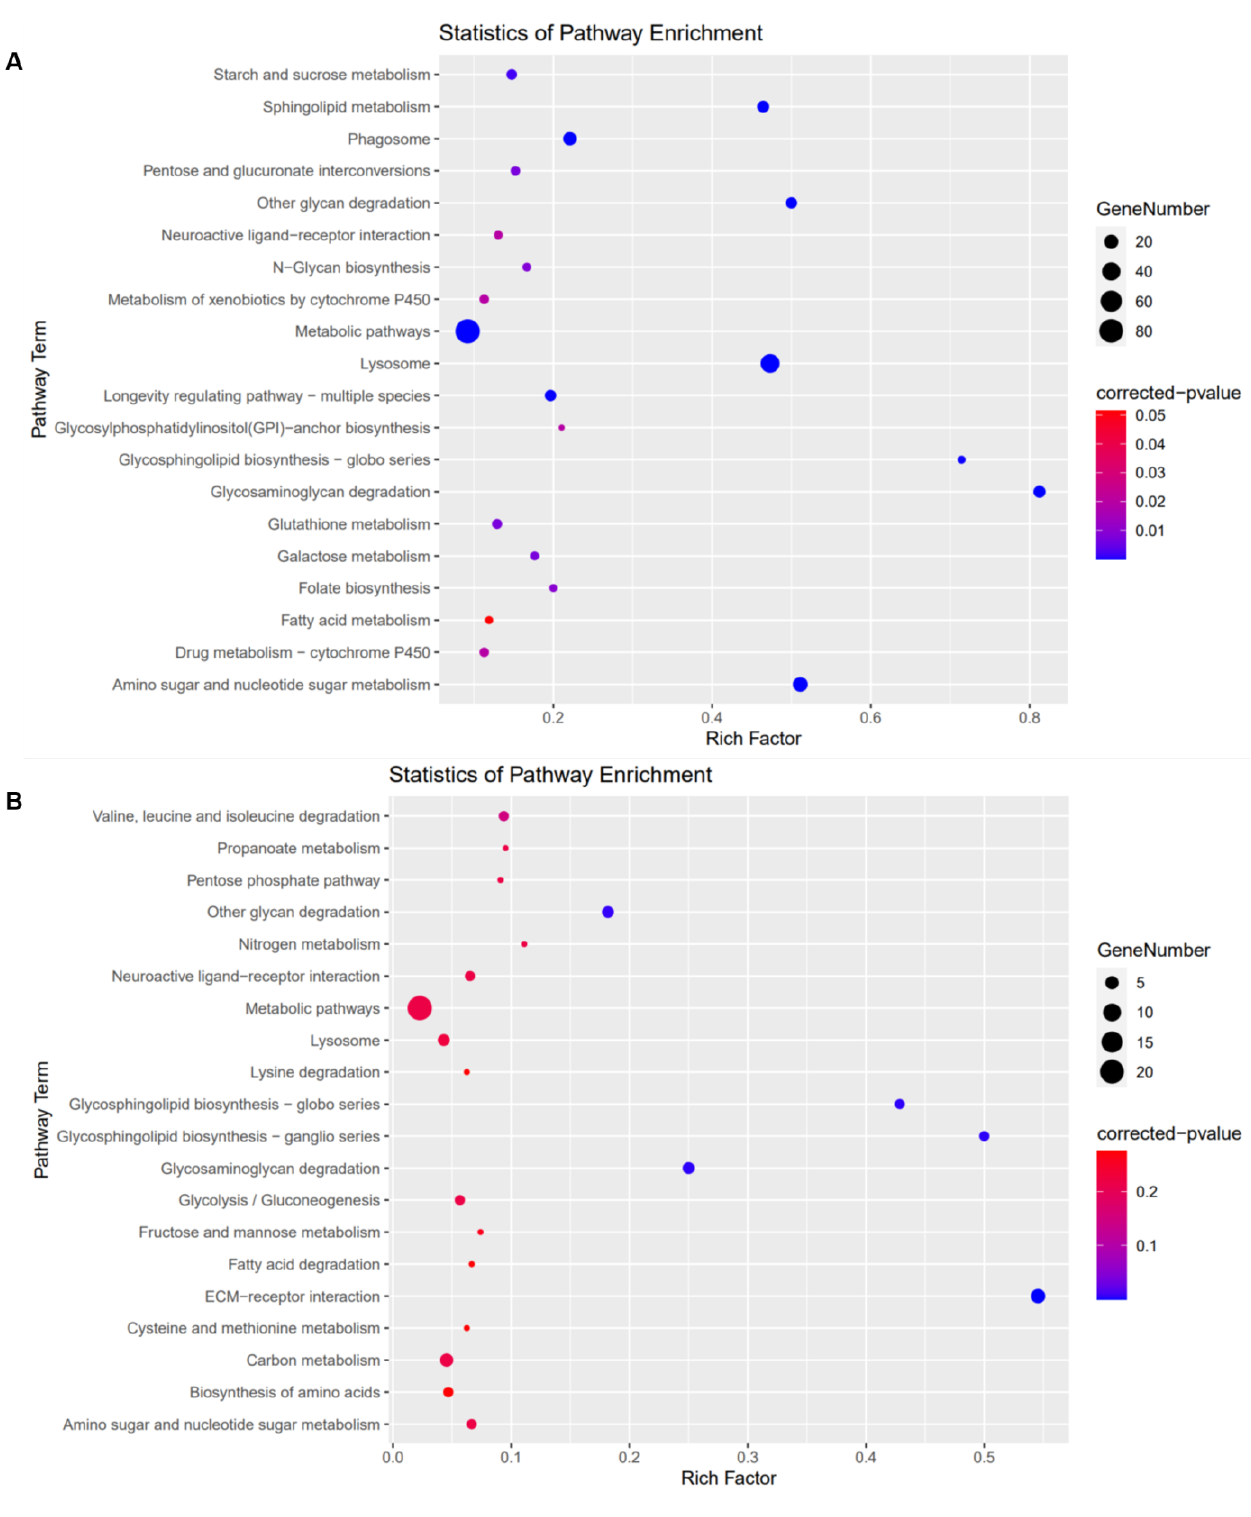
Figure 3. The KEGG significant enrichment pathway in HC_O vs. CG_O group. ( A ) Up − regulation pathways in HC_O vs. CG_O group; ( B ) down − regulation pathways in HC_O vs. CG_O